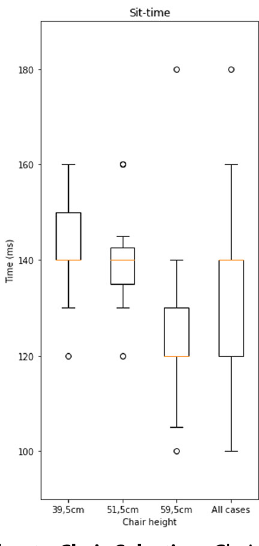
Fig. 6 Variability due to Chair Selection. Chair height as a SoV for sit-to-stand transition time tests. Variability is considerably larger when considered across chairs. The error bars of boxplot are generated by matplotlib using the matplotlib.pyplot.boxplot func- tion with default parameters. The boxplot extends from the fi rst to the third quartile of the data with a line at the median. The whiskers extend from the box by 1.5 times the inter-quartile range.